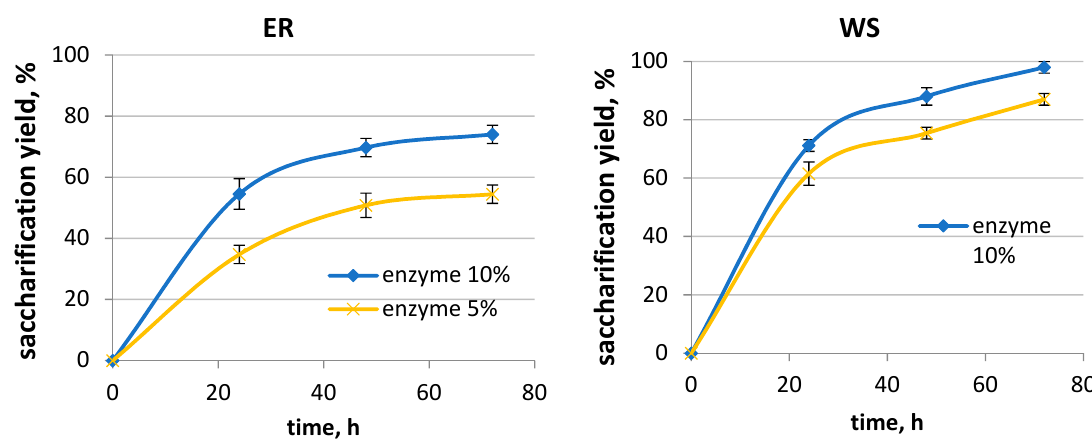
Figure 10. Enzymatic hydrolysis yields of the CF from ER ( left ) and WS ( right ) at different enzyme dosages.